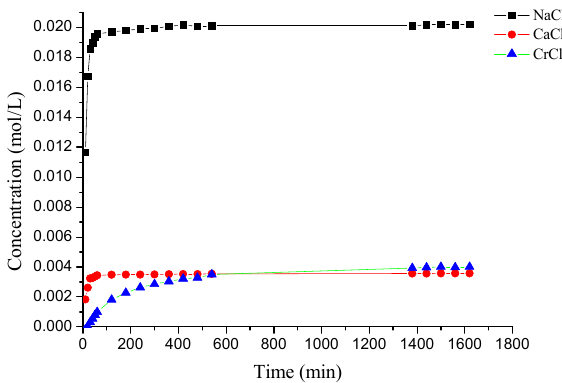
Figure 12. The desorption kinetics of γ -PGA/ ε -PL hydrogels in ion solutions.